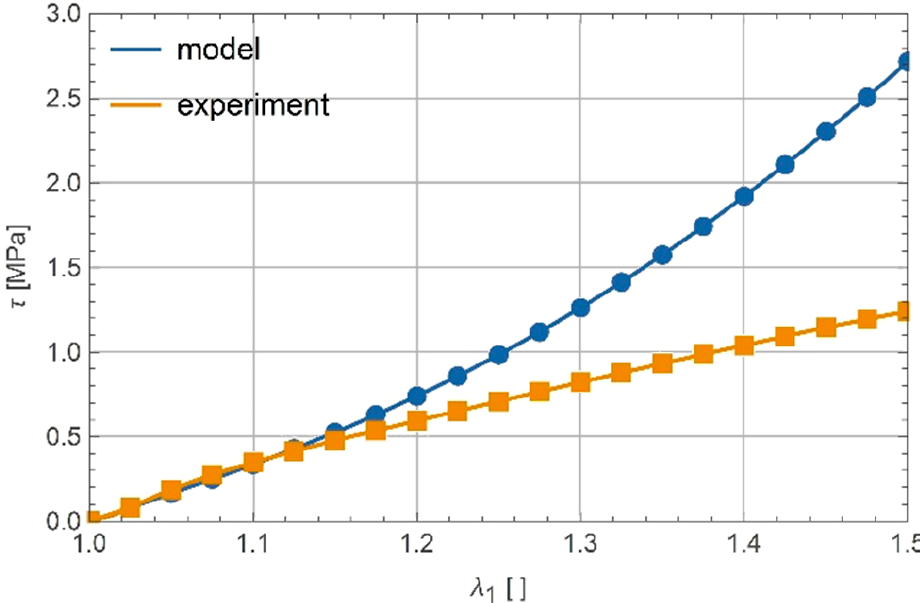
Figure 8. Response in shear with 𝛼 and 𝛽 calibrated for tension. Similarly, the model gave a poor prediction if α and β obtained from the calibration of shear response were used to model tensile response (see Figure 9).